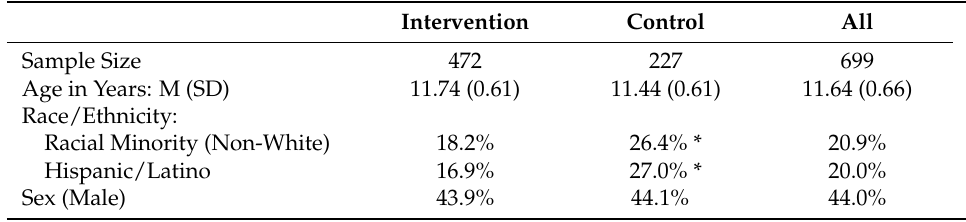
Table 4. Baseline Demographics by Condition.